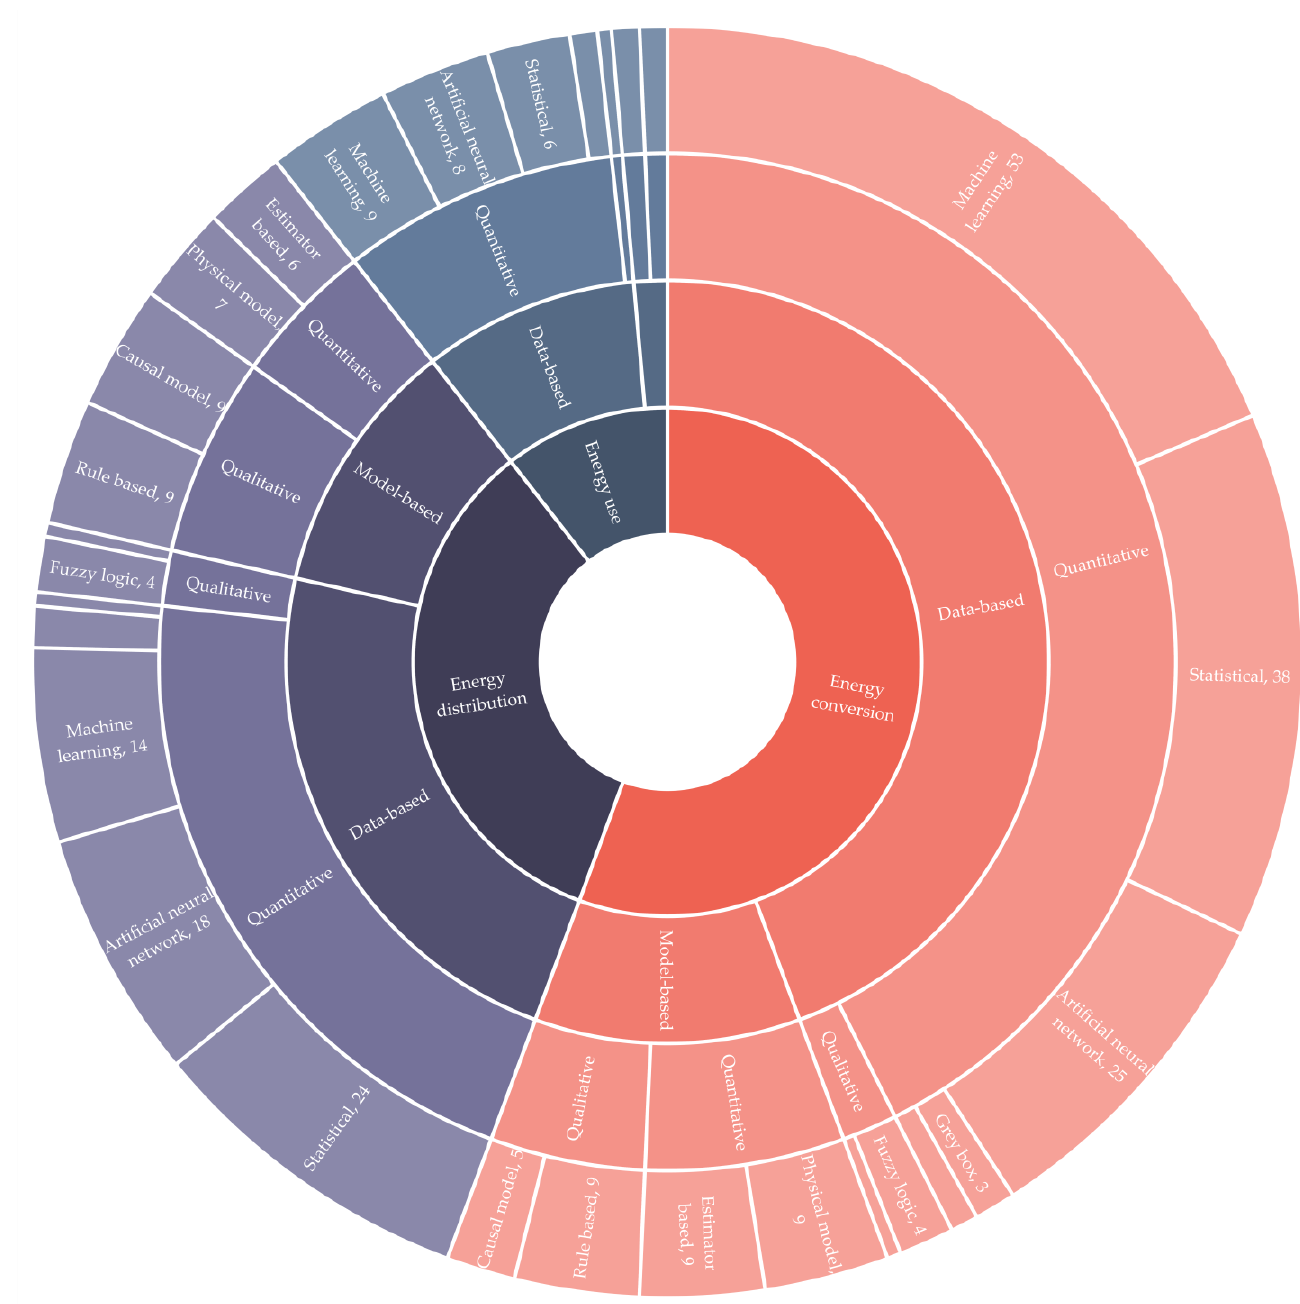
These categories are further described in the respective literature presented in Table 4.